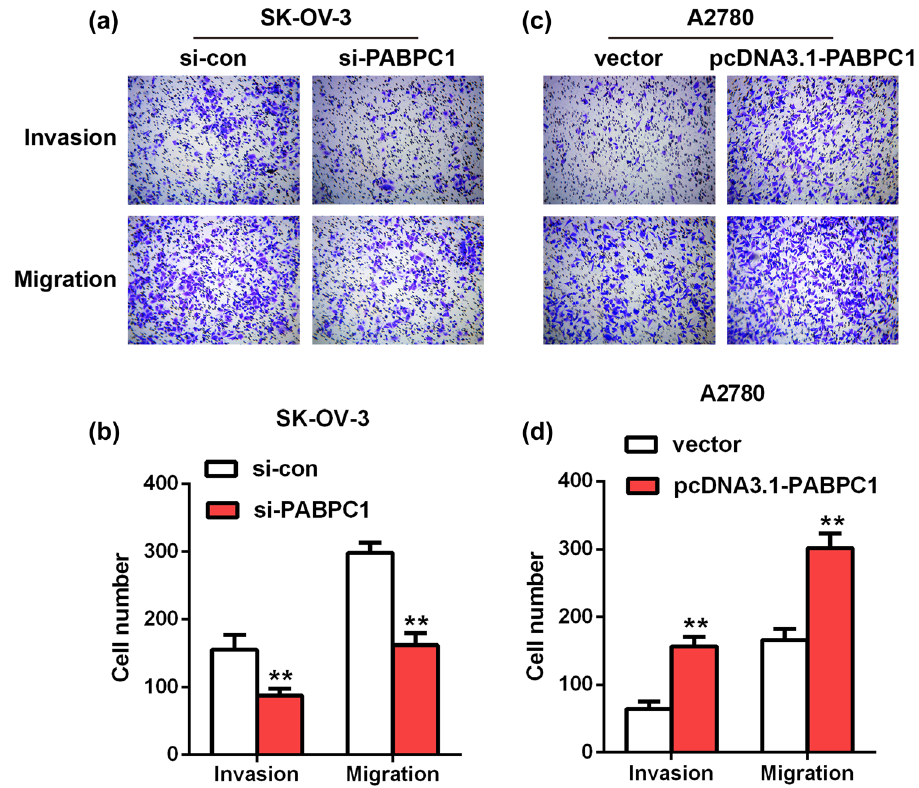
Figure 4: Impacts of downregulation and upregulation of PABPC1 on invasion and migration. The impacts of PABPC1 knockdown on SK - OV - 3 cells ( a and b ) and the impacts of PABPC1 overexpression on A2780 cells ( c and d ) invasion and migration were measured by Transwell assays.** P < 0.01 vs si - con or vector